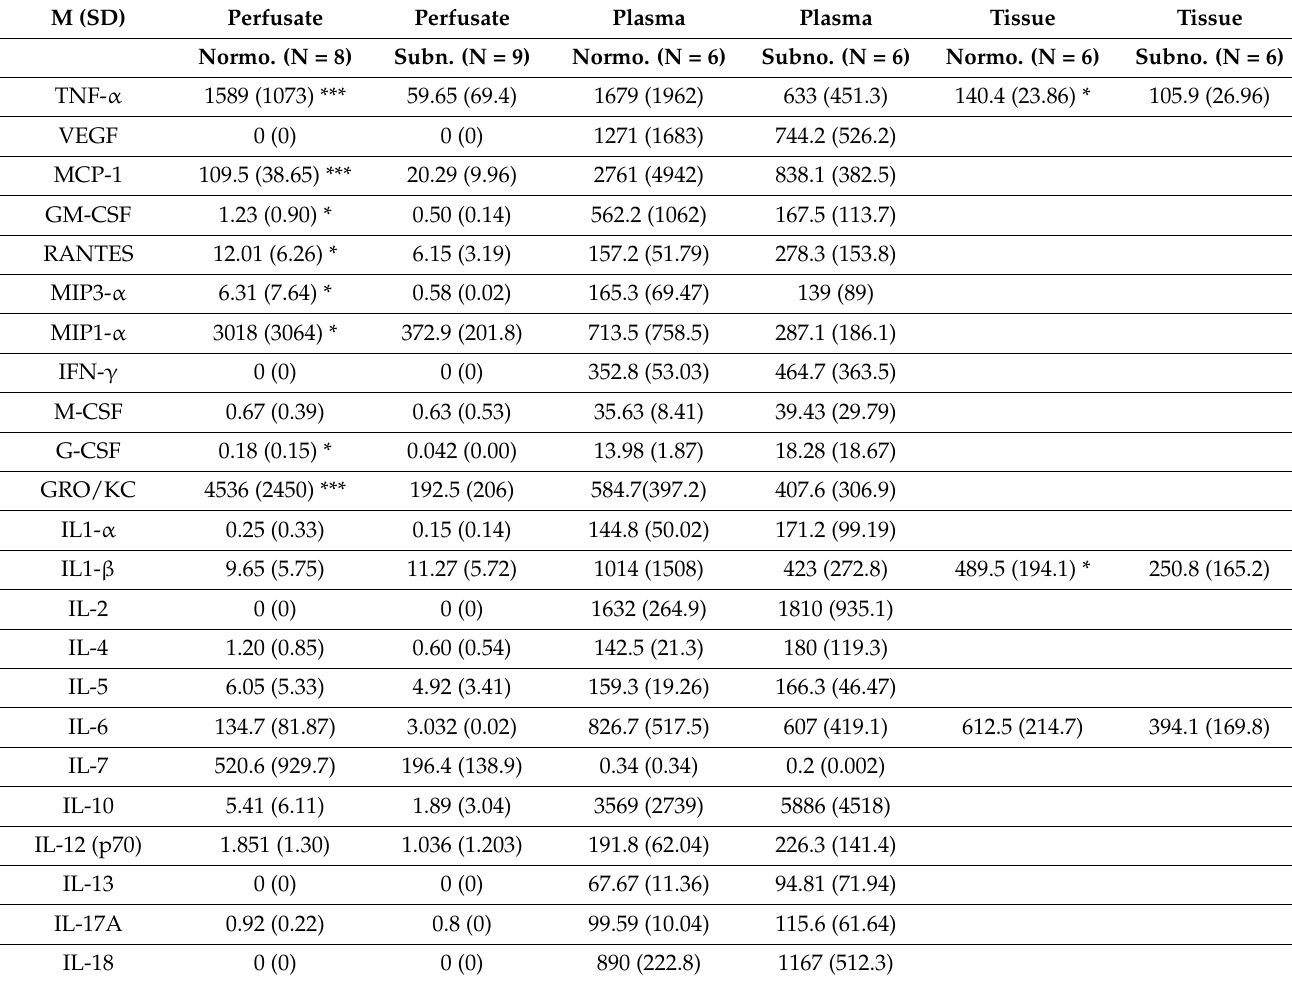
Table 1. Perfusate, plasma and tissue cytokines, chemokines and mediators of wound healing and tissue repair in the study